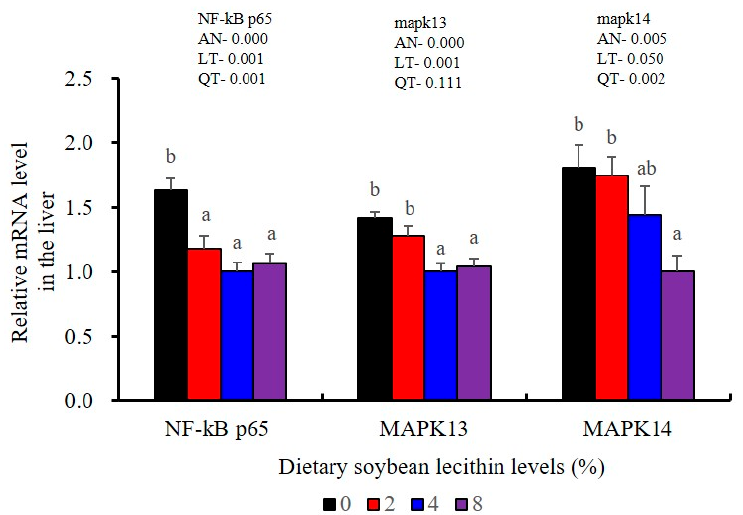
Figure 4. Effects of dietary soybean lecithin on relative gene expression levels of mitogen-activated protein kinase (MAPK) signal pathway in the liver of juvenile largemouth bass. Bars with different letters indicate significant differences ( p < 0.05), while that with the same letter or no letter superscripts indicate no significant differences ( p > 0.05), AN: ANOVA, LT: linear trend, QT: quadratic trend.